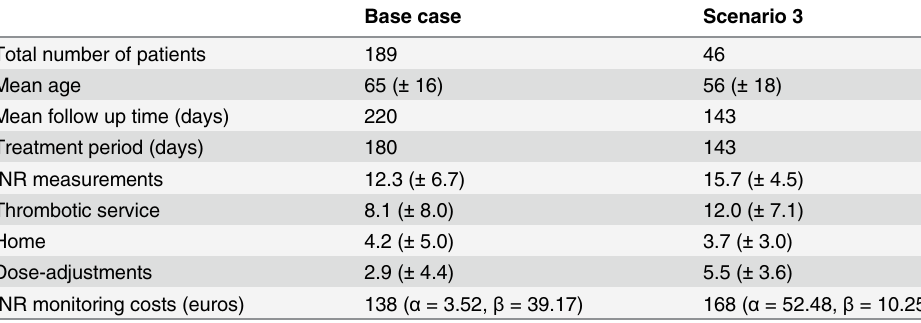
Table 1. Resource utilization and costs of INR